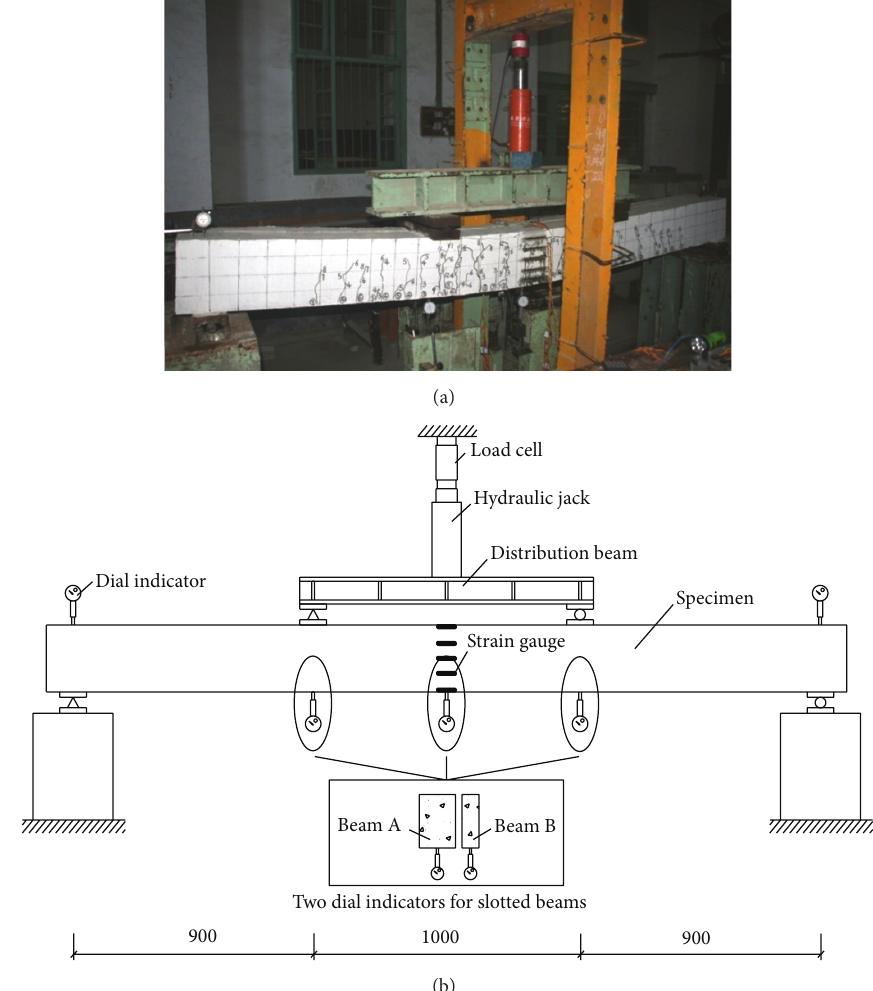
Figure 3: Four-point bending test system of the RC beams: (a) photo of the test devices; (b) sketch of the test devices (units: mm).